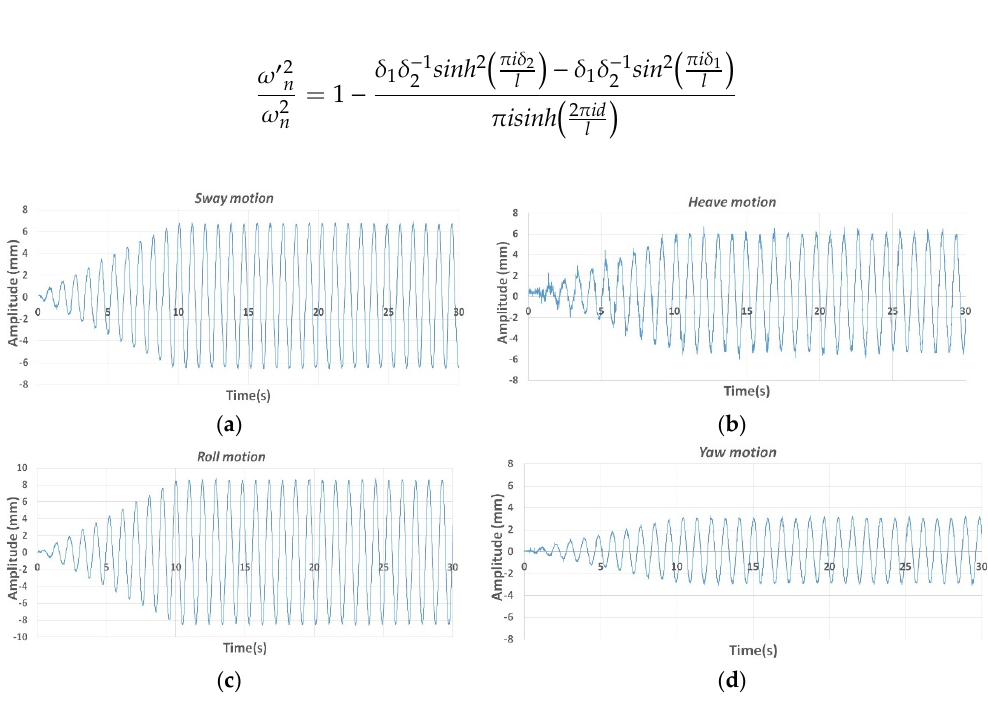
Figure 3. Time histories of forced oscillation motions with maximum amplitudes ( a ) sway, ( b ) heave, ( c ) roll, and ( d ) yaw.